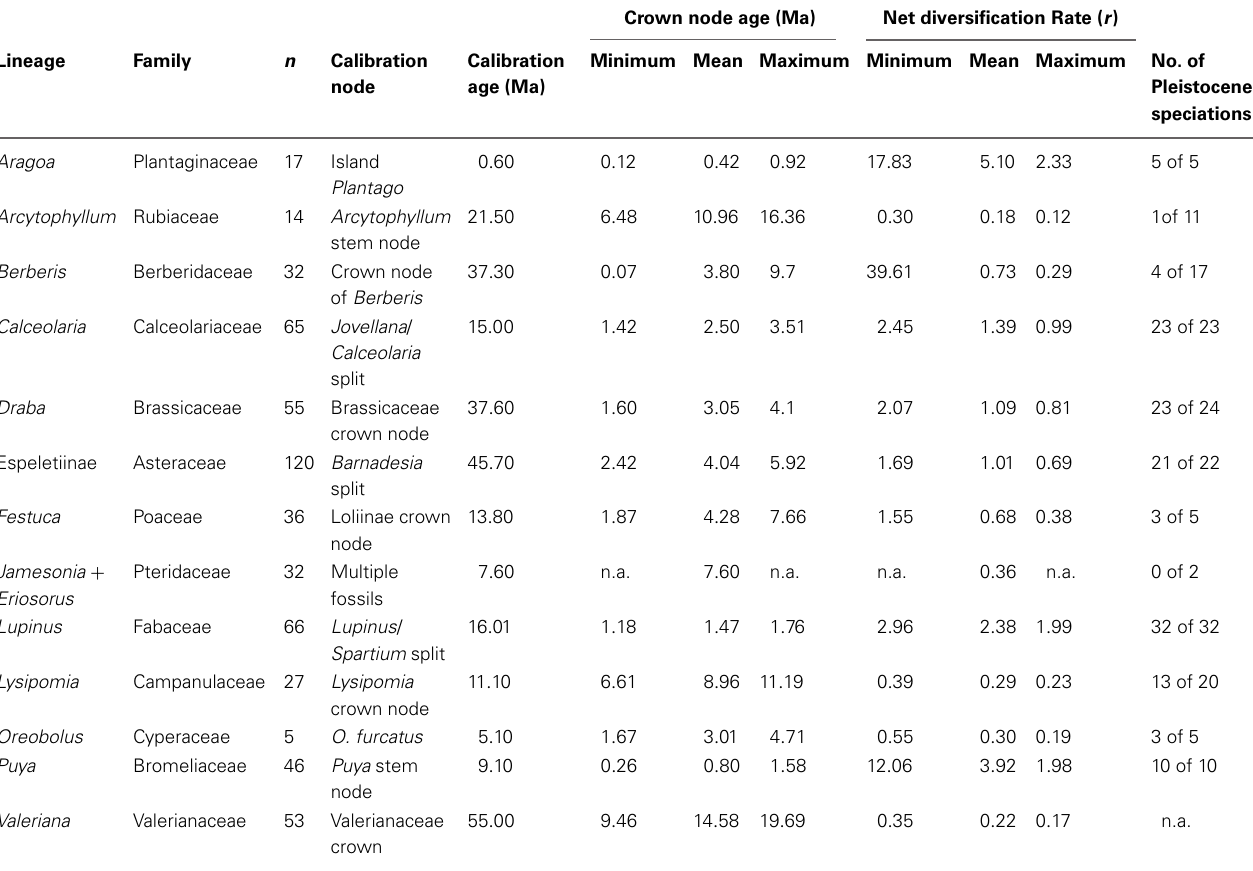
Table 1 | Net diversification rates of Páramo plant lineages.